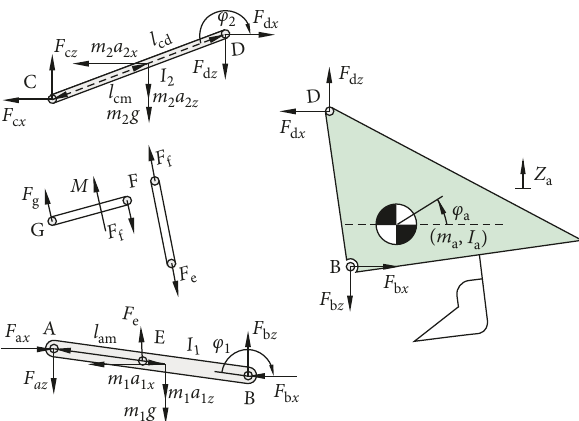
Figure 5: Model of three-point hitch